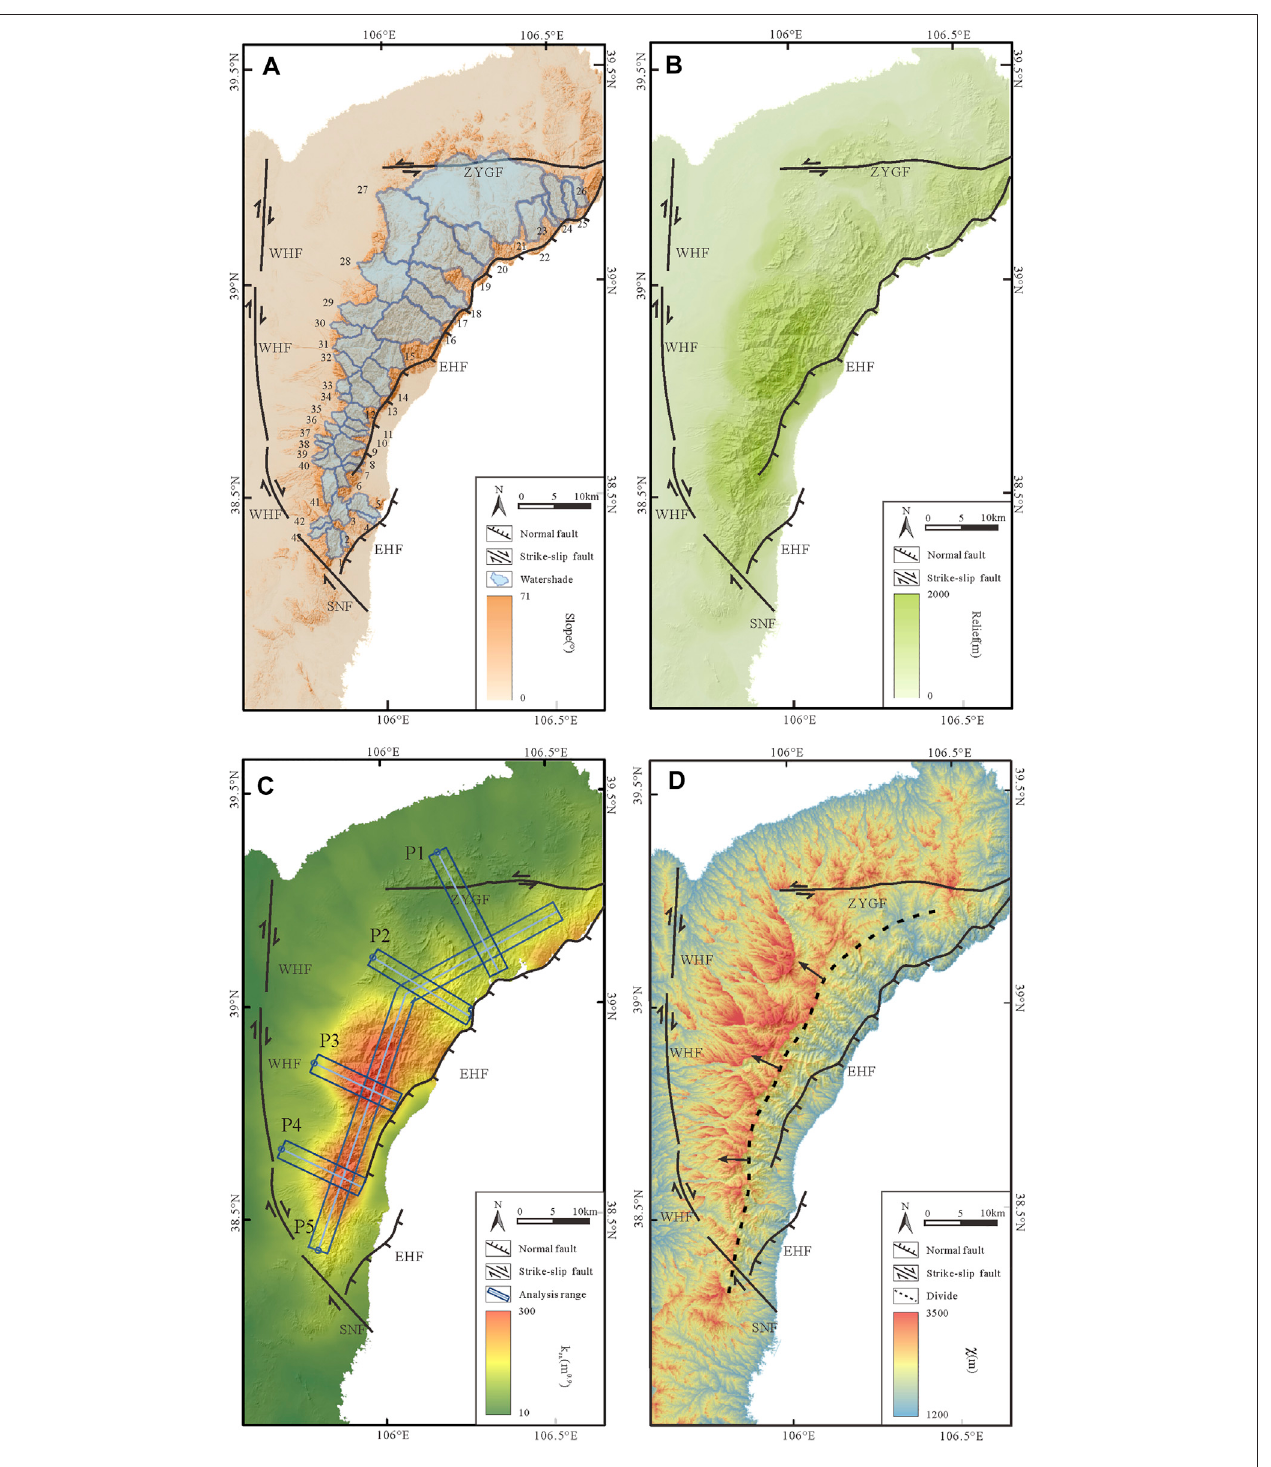
FIGURE4|(A) Slopemapshowingthelocationsofthestudieddrainageareas.1 – 26arelocatedattheeasternfootoftheHelanShan,and27 – 43arelocatedatthe western foot of the Helan Shan. (B) Relief map obtained by calculating the difference between the maximum and minimum elevation values within a radius of 5 km. (C) Normalized steepness index map. The dark blue frame, the blue circle, and the light blue line represent the sampling range starting point and the centerline of the strip, respectively. (D) χ mapoftheHelanShanwiththeactivefaults.Theblacklinesrepresenttheactivefaults,black-dottedlinerepresentsthedivideposition,andblack arrows represent the divide migration direction.